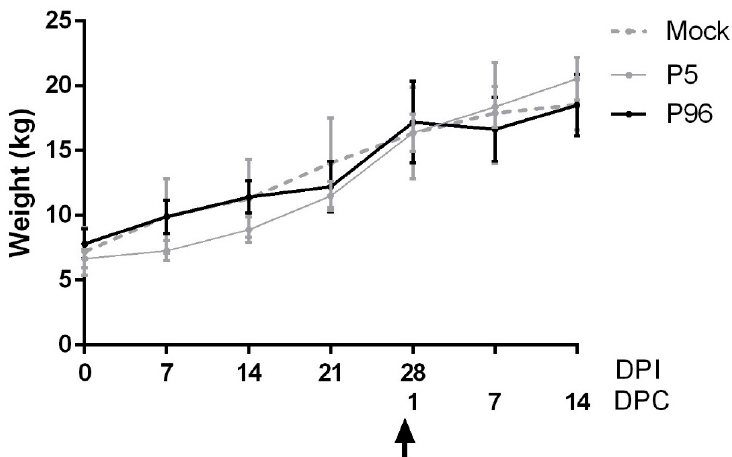
Figure 2. Weekly change in the body weight of 5-week-old pigs after porcine epidemic diarrhea virus strain Pintung 52 (PEDVPT)-P5 or PT-P96 inoculation. The weekly differences in mean body weight for each group are shown as mean ± standard error of the mean (SEM). The black, gray, and dashed lines illustrate the values obtained for the PEDVPT-P96-inoculated group, PEDVPT-P5-inoculated group, and mock-infected group, respectively. The arrow indicates the time point when the pigs were challenged with the low passage PEDVPT-P5 (27 DPI or 0 DPC) strain. P5: low passage virus, PEDVPT-P5; P96: high passage virus, PEDVPT-P96; mock: PI medium control; DPC: days post-challenge.